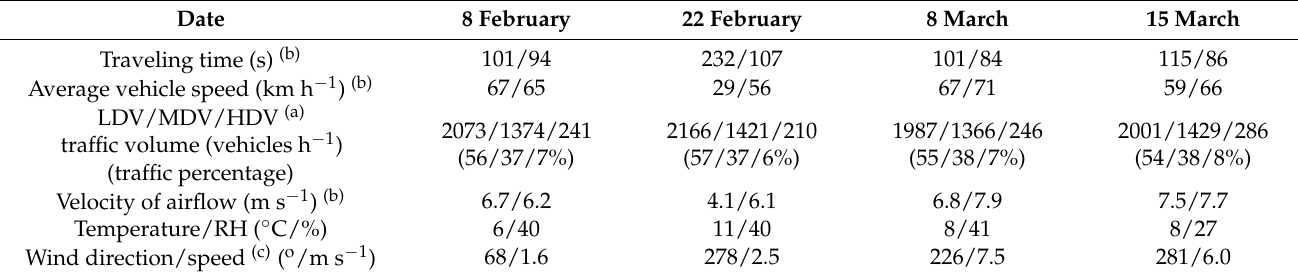
Table 1. Outlines of the mobile monitoring measurements from inside the